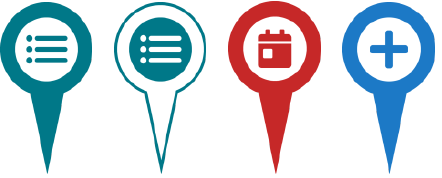
Figure 3. Application symbols. From left to right: observation, my observation, event, manually selected position A single colour has been chosen for each item using white as a neutral background to increase contrast and visibility. For observations and measures, the SIMILE project colour, a combination of blue and green (RGB 0, 120, 136), has been used in order to communicate a good environmental quality granted by a regular monitoring activity and efficient authorities, as emerged from the previous tests. This colour, taken from the corresponding axes (5) of the Interreg program, makes also a good contrast with the light blue of lake water of the OpenStreetMap (RGB 171, 211, 223) background tiles. The choice of the symbol has been driven by the need of adopting something quite generic and able to communicate the possibility of inserting more than one option. For that reason, a “list” icon has been chosen (list-filled, www.ionicons.com). A negative version of this marker has been used to recognize user’s own observations (second symbol in Figure 3).